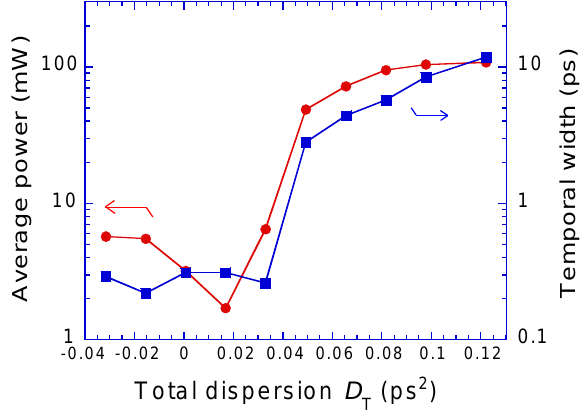
Figure 13. Variation of maximum average power and temporal width of output pulse as a function of net dispersion, D T